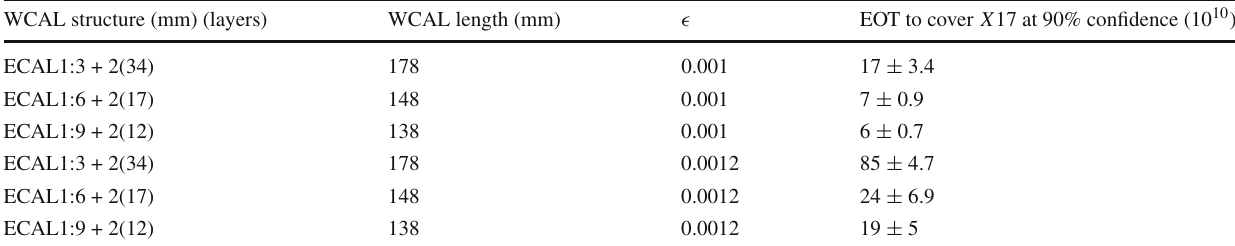
Table 4 Number EOT required to cover X 17 at 90% confidence using different WCAL designs in the visible mode setup proposed for 2021. The first entry describes the structure using the convention: [ECAL]: [converter-depth] + [counter-depth] (number-of-layers) WCAL structure (mm) (layers)